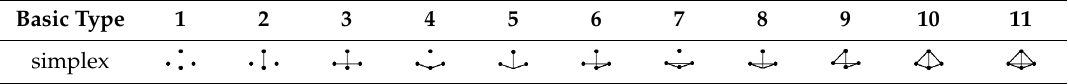
Table 3. Basic types of simplexes.